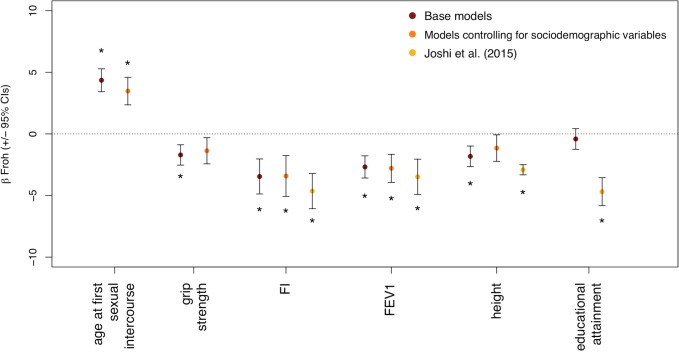
Comparison with estimates from Joshi et al. 2015, and some evidence that sociodemographic background variables attenuate the relationship between FROH and complex traits.Plot shows the Beta FROH and 95% confidence interval in within-sex standardized phenotypic units for the five quantitative traits that were significantly associated with FROH in the main models (Fig 1), as well as educational attainment, which was significantly associated with autozygosity in Joshi et al.’s study7. Estimates that were statistically significant after multiple testing corrections are starred for each set of models. After controlling for background sociodemographic characteristics, AFS, FEV1, and FI were still statistically significant in our study. The effect sizes for AFS, grip strength, FI, and height all decreased after controlling for sociodemographic variables. The effect sizes from our analyses were smaller for all four of the phenotypes also measured in Joshi et al.’s study. FI, fluid intelligence; FEV1, forced expiratory volume in 1 second; CI, confidence interval.